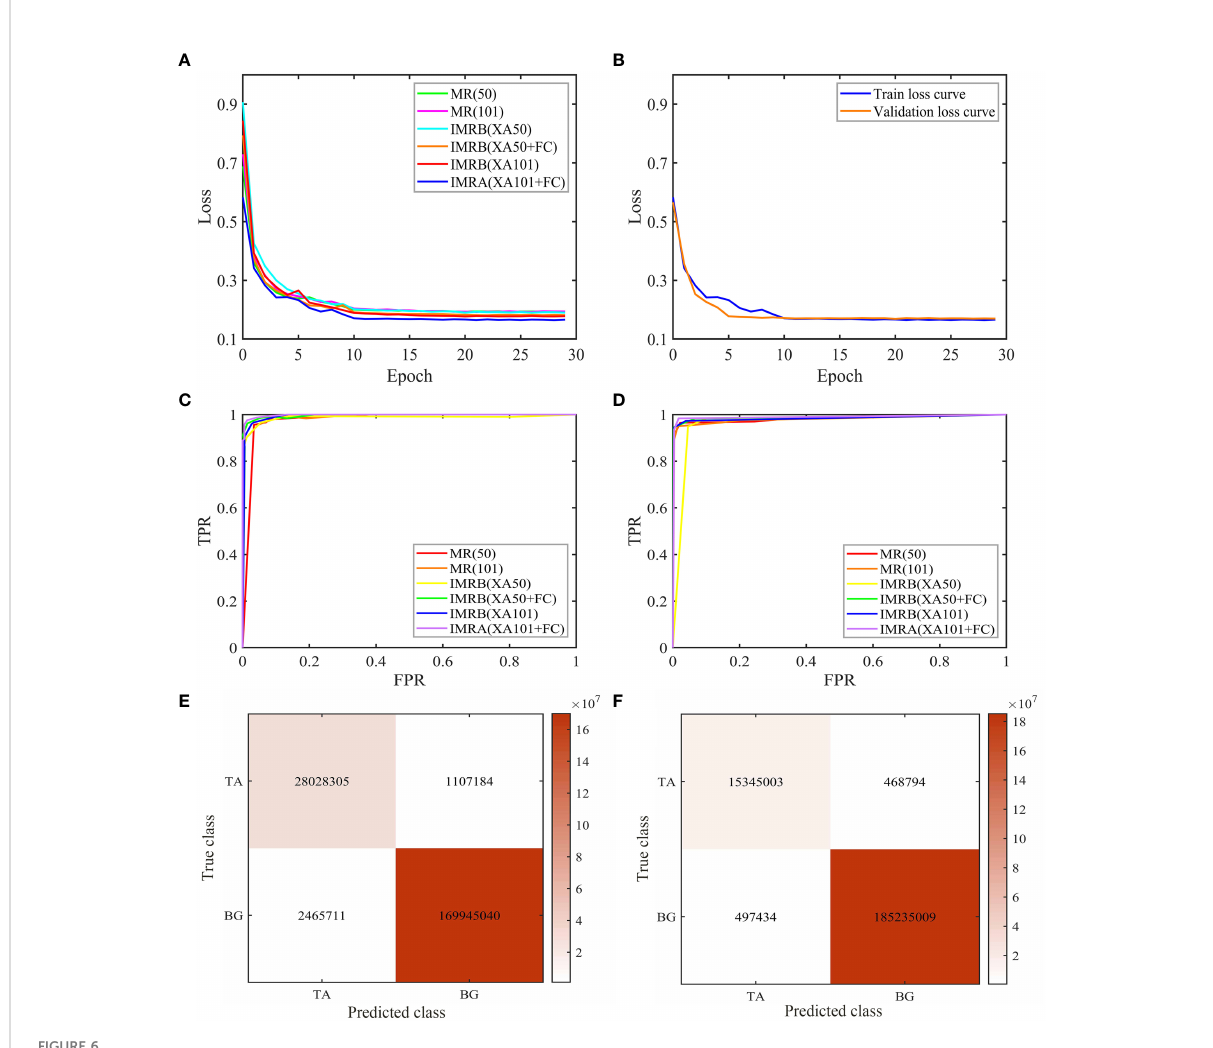
FIGURE 6 Comparative experiment results of six models. (A) Loss curves of different models in the training stage. (B) Loss curves of IMRA(XA101+FC). (C) Detection ROC curves of different models. (D) Segmentation ROC curves of different models. (E) Detection confusion matrix of IMRA(XA101+FC). (F) Segmentation confusion matrix of IMRA(XA101+FC). ( “ tapped area ” : TA, “ background ” :